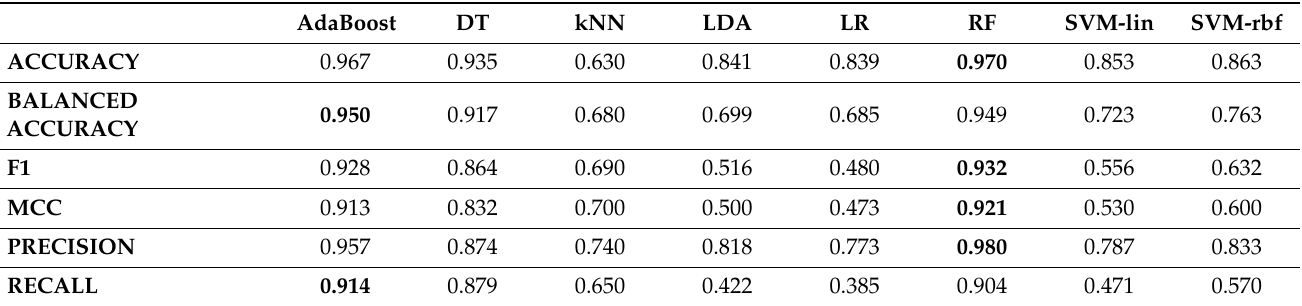
Table 4. Metrics for performance evaluation of the session-independent approach (for each metric, the best performance results are identified in bold).